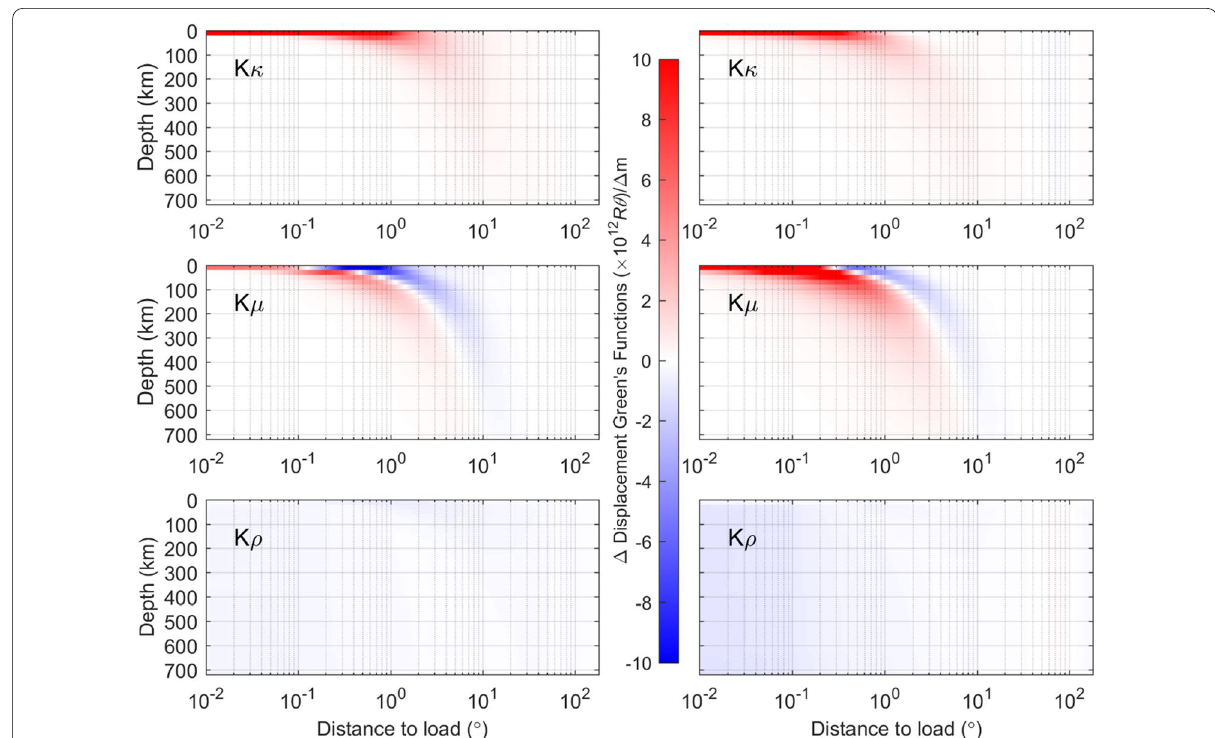
Fig. 5 Similar to Fig. 4 except that we perturb layers of 20 km thickness. The sensitivities of displacement Green’s functions to perturbations of the bulk modulus, shear modulus, and density in layers with a fixed thickness of 20 km at depths from 0 to 700 km instead of the major regions of TW1